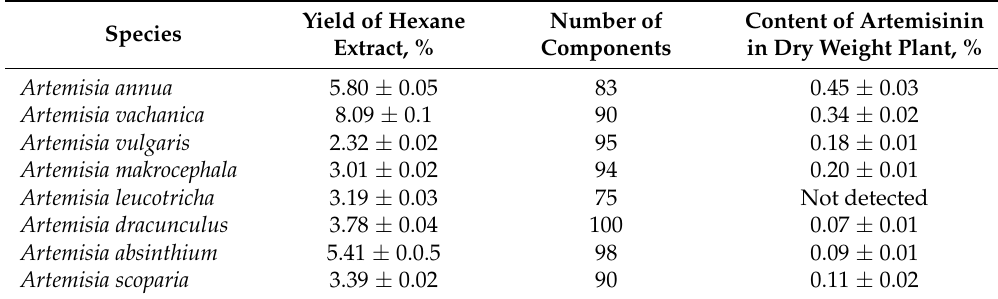
Table 2. Extraction yield, componential composition, and artemisinin content in Artemisia species.